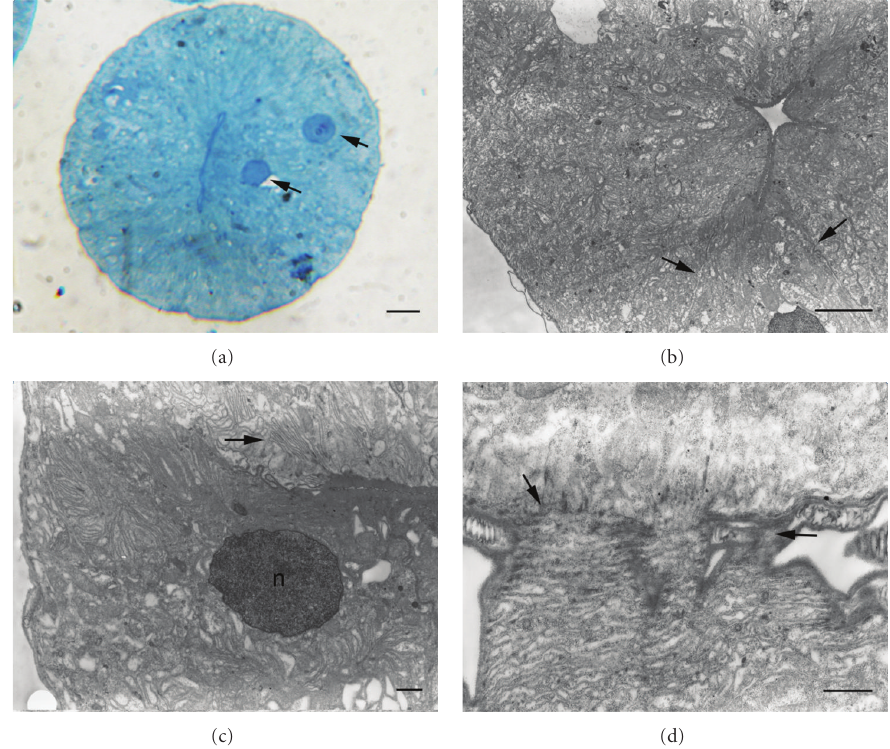
Figure 2: Micrographs of the salivary gland in adult male C. megacephala . (a) Light micrograph of the thick section showing the narrow central gland lumen. Arrows indicate a large nucleus. Bar = 5 µ m. (b–d; TEM micrographs) (b) Compartment of the gland context (arrows). Bar = 5 µ m. (c) Baso-lateral region of the gland cell, exhibiting infoldings of the basement membrane (arrow). A large nucleus (n) is observed. Bar = 1 µ m. (d) Interdigitation of cytoplasmic extensions between the adjacent gland cells (arrows). Bar = 1 µ m.